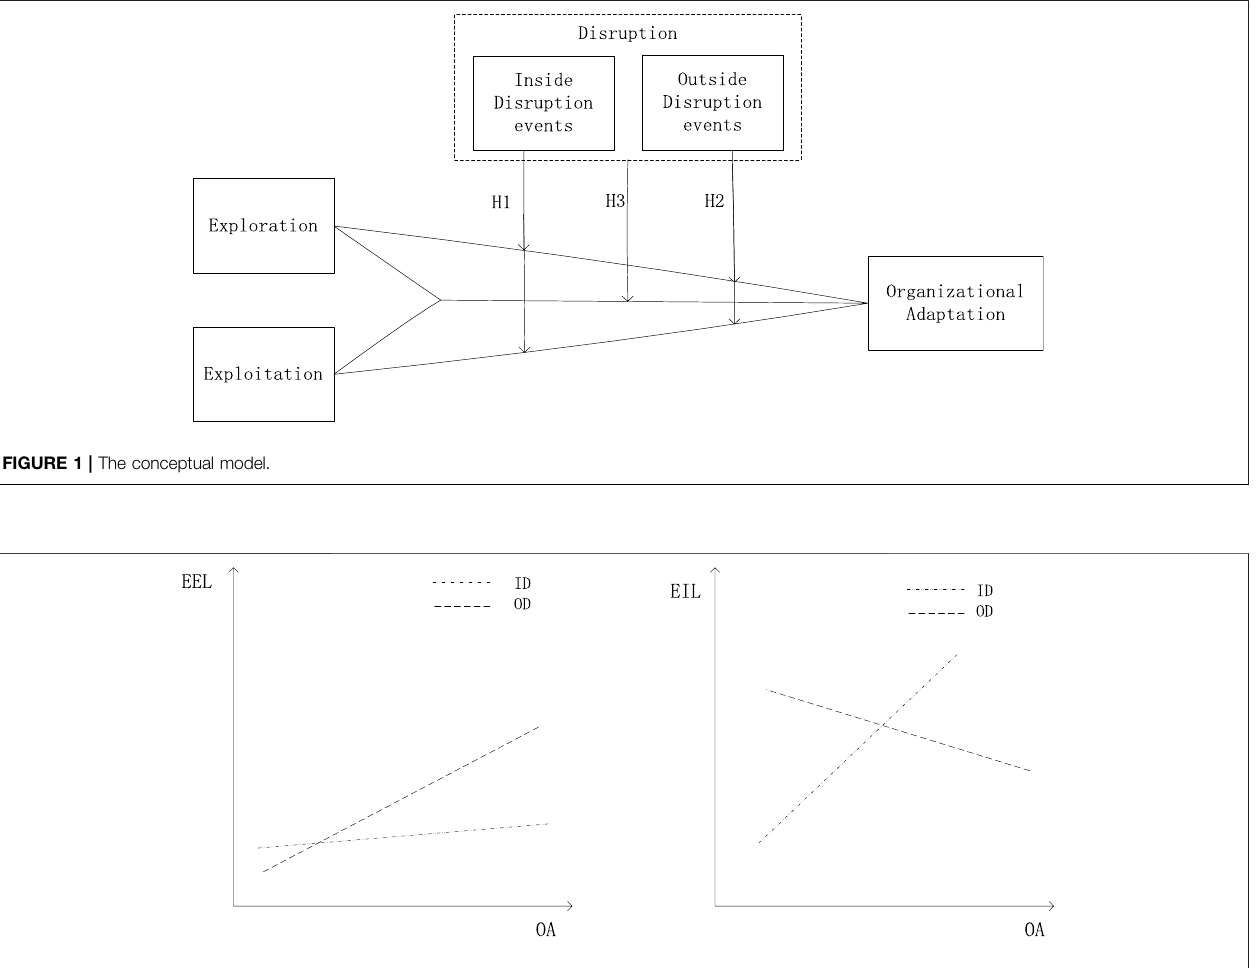
FIGURE 2 | Schematic diagram for the regulating effect of variable.